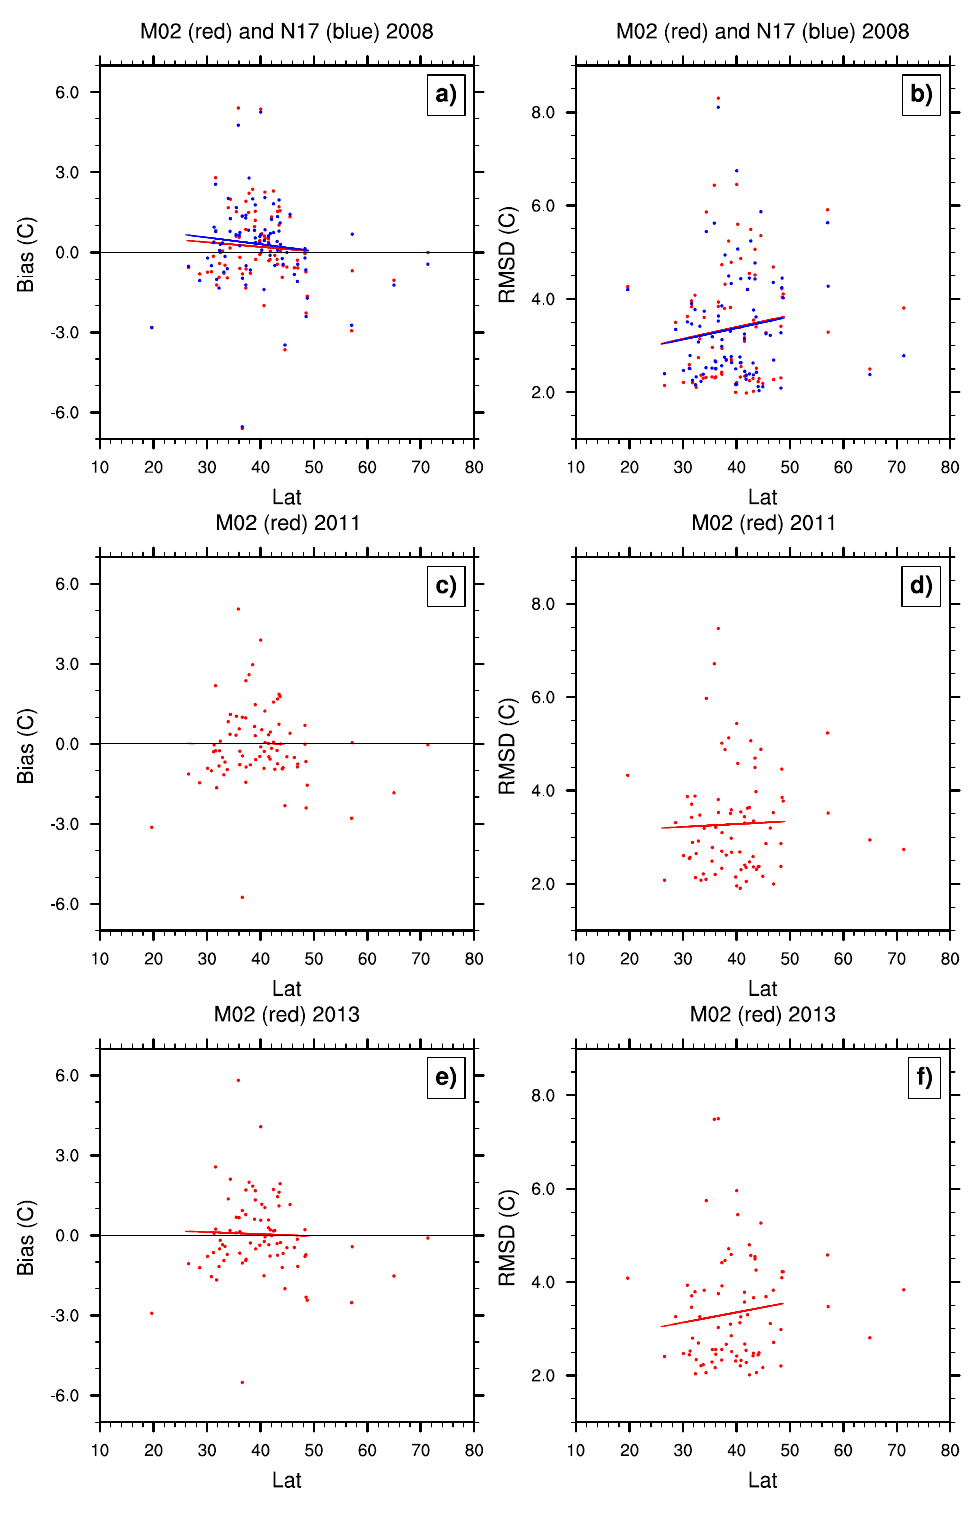
Figure 7. Similar to Figure 6 for scatter plots of annual mean bias and RMSD (°C) of HIRS SAT co-located to each USCRN station along latitude for 2008 ( a , b ); 2011 ( c , d ); and 2013 ( e , f ).